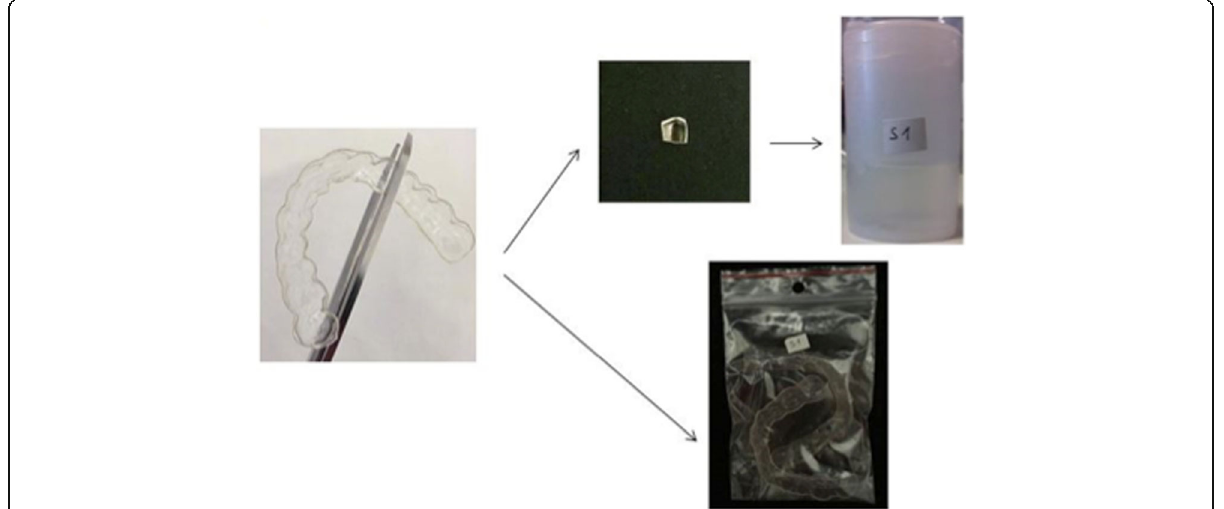
Fig. 1 Processing a used aligner before sending to the